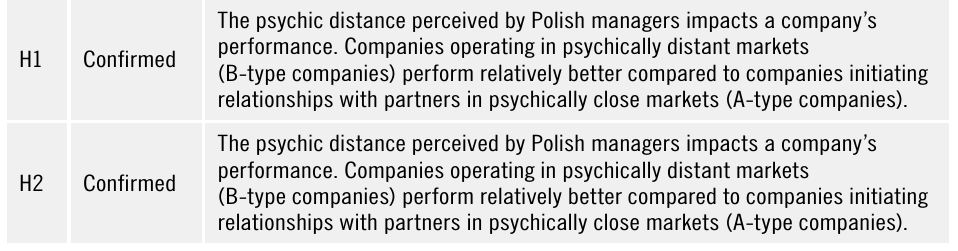
Table 9. Hypotheses